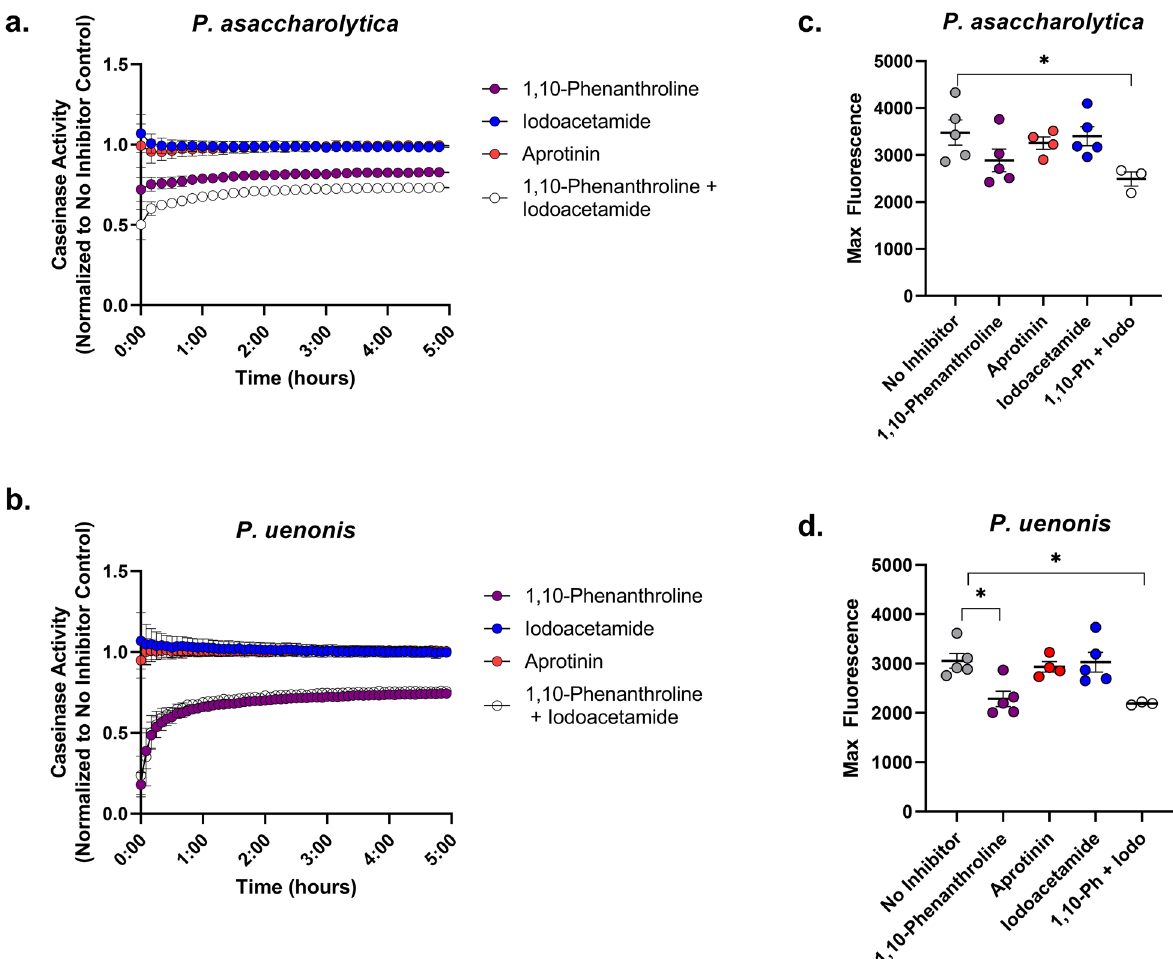
Fig. 4 P. asaccharolytica and P. uenonis secreted metalloproteases have broad substrate speci fi city. a , b Cell-free supernatants of a P. asaccharolytica and b P. uenonis were incubated with fl uorophore-conjugated casein in the presence of the metalloprotease inhibitor